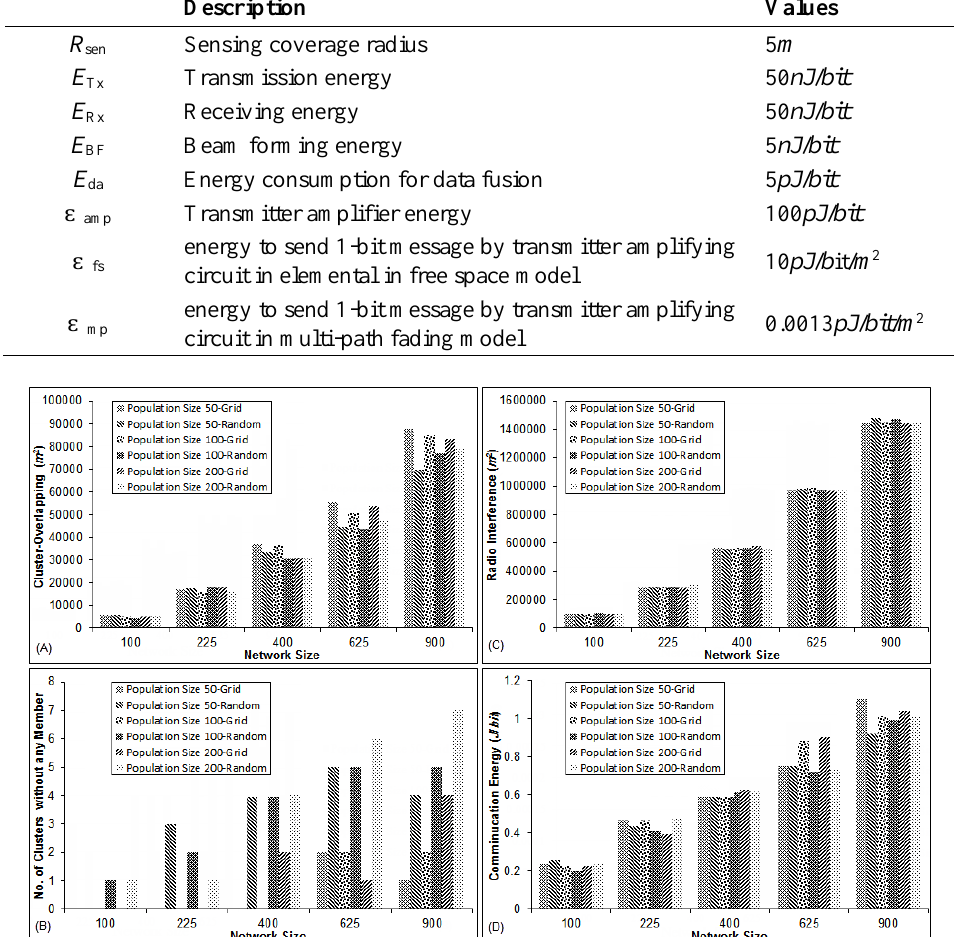
Figure 1. Cluster-overlapping (A), no. of clusters without any member (B), radio interference (C), and communication energy (D) versus network sizes with different population sizes.